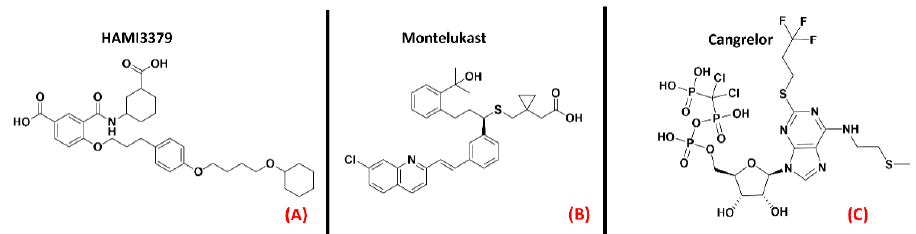
Figure 14. The chemical structures of the GPR17 inhibitors. The non-selective inhibitors HAMI3397, Montelukast (sold as a CysLT receptors inhibitor for asthma), and Cangrelor (an antiplatelet drug, reversible inhibitor of P2Y 12 receptor), respectively ( A – C ).